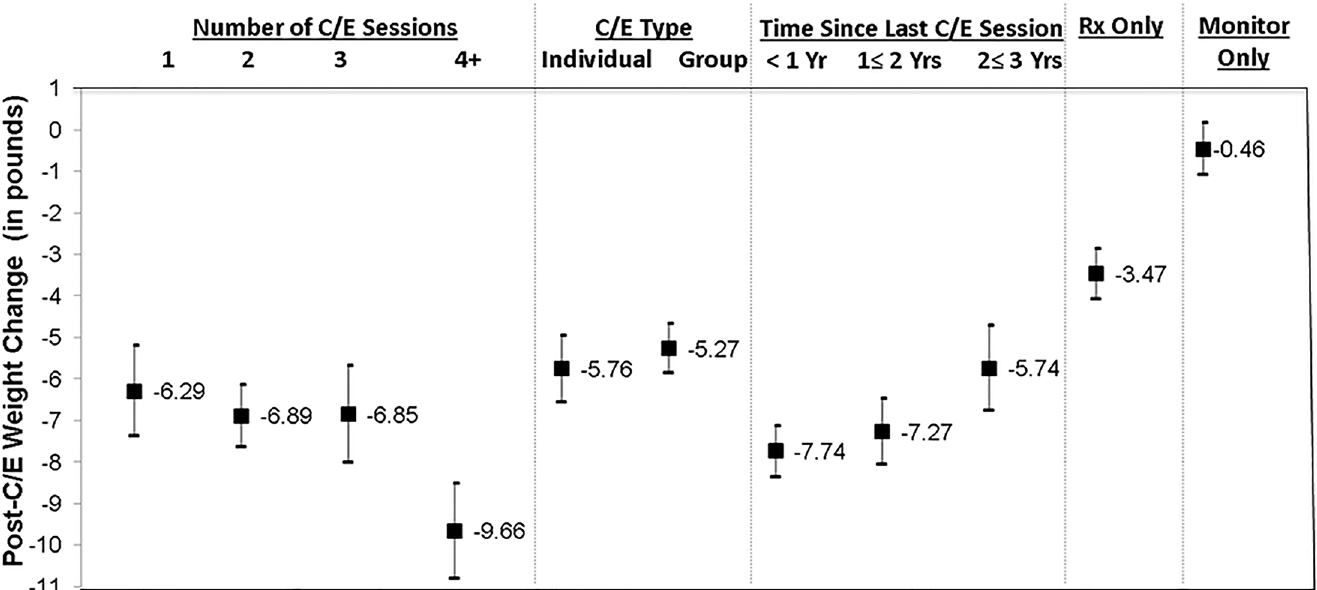
Fig 1. Weight Change Associated with Doses and Types of Counseling/Education (C/E) (a)(b) . (a) Classification of C/E type is based on those who received any C/E, regardless medication prescription or not. (b) Estimates are from propensity-score adjusted individual random effects models (Number of observations = 16,064; Number of patients = 1,314). Coefficient and 95% Confidence Intervals are presented above. In all the models, patient clinical and demographic characteristics (any medication prescription during 12 months follow-up, any education within 1 year prior to baseline, fasting blood glucose level at baseline, height, age, sex, race/ethnicity, comorbidities (cardiovascular disease, dyslipidemia, hypertension), smoking status, frequency of primary care visits during 12 months follow-up, any endocrinologist visit during 12 months follow-up) were included. For the estimation of propensity score, additional variables indicating physician order of education/counseling during 12 months follow-up and initial body weight was included.